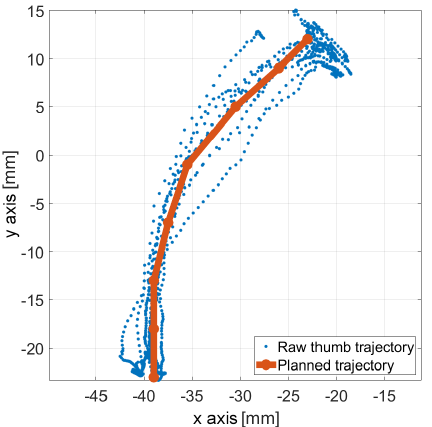
Figure 18. An example of the trajectory planning result of FE